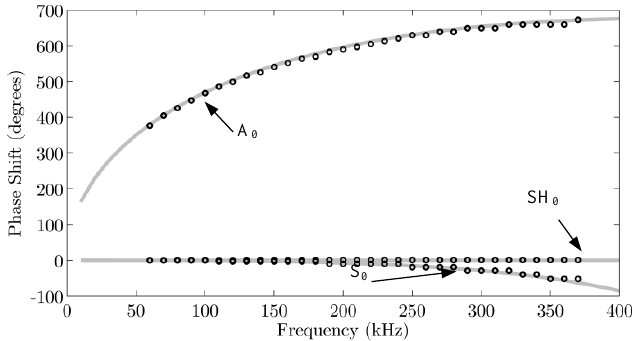
Figure 8. Comparison of the phase shift of S 0 , A 0 and SH 0 between the results from the synthesized signals (black circles) and theoretical values (grey lines).